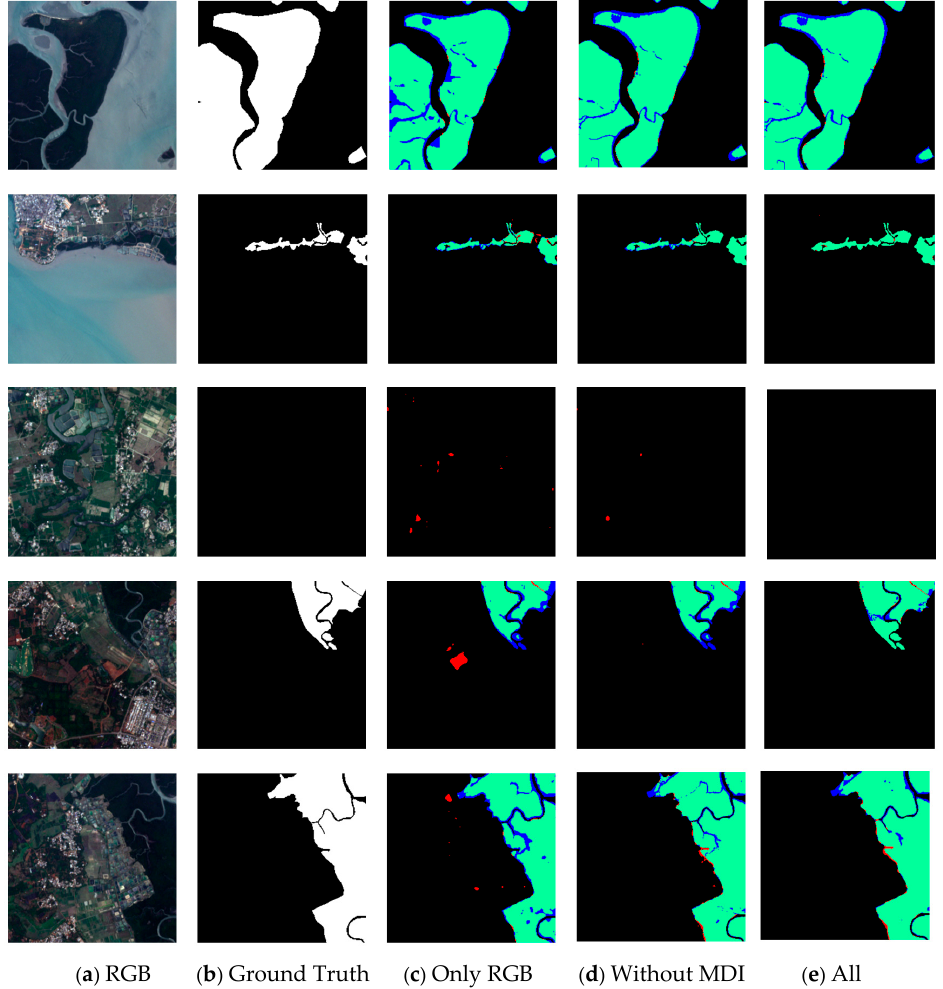
Figure 12. Effect of some sample data on the result of mangrove exaction under the ME-Net model. The first column ( a ) shows the actual color of the remote sensing imagery; the second column ( b ) shows the corresponding ground truth; the third column ( c ) shows the prediction result of the model after adding only three bands of RGB; the fourth column ( d ) shows the prediction result after adding MDI; the fifth column ( e ) shows the prediction result after adding five original bands and six multispectral indices. Green, red, blue, and black represent the TP, FP, FN, and TN, respectively. In different experimental scenarios, we compared the results (Figure 12) to explore the impact of adding different sample data to the ME-Net model on the performance of mangrove extraction (the IoUs for data are shown in Table 7). The experiment results showed that some FP pixels would appear in the prediction results of the model when only three bands, R, G, and B, were used. The actual color of the remote sensing imagery indicated that it is a classical phenomenon of “different objects with the same spectra”.